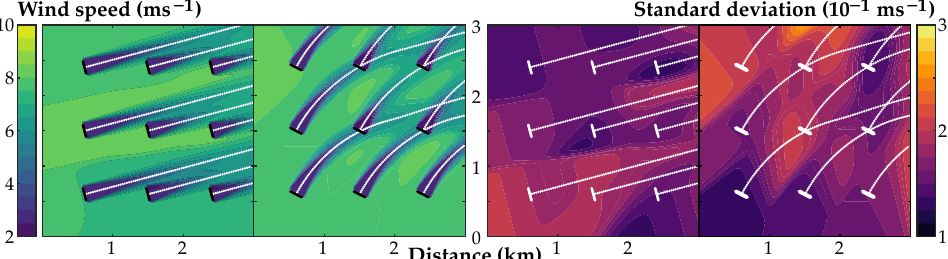
Figure 9. The estimated effective wind speed flow field is depicted in the left figure pair, once in steady state at t 1 = 600 s and once at t 2 = 840 s, during the wind direction change. The right figure pair shows the respective standard deviation.